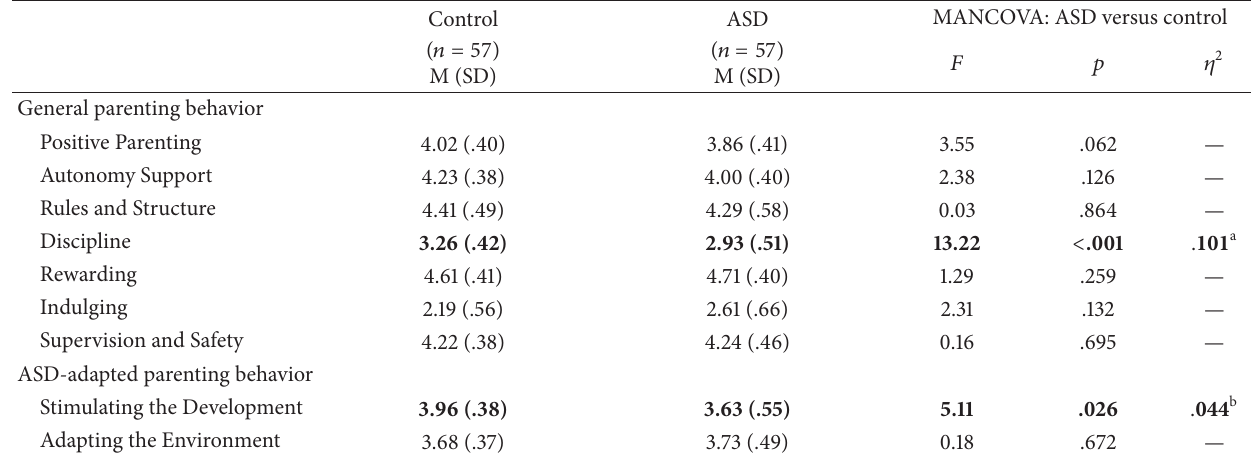
Table 2: Group differences in parenting behavior between the ASD and control group. Control ASD MANCOVA: ASD versus